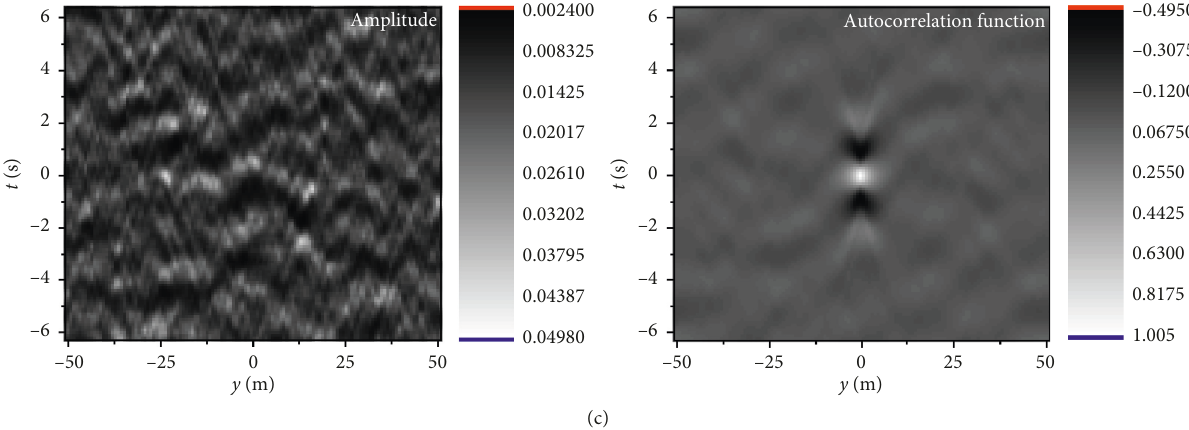
Figure 6: The amplitude and autocorrelation function of 3D sea clutter by the statistical model. (a) xOt plane. (b) xOy plane. (c) yOt plane.